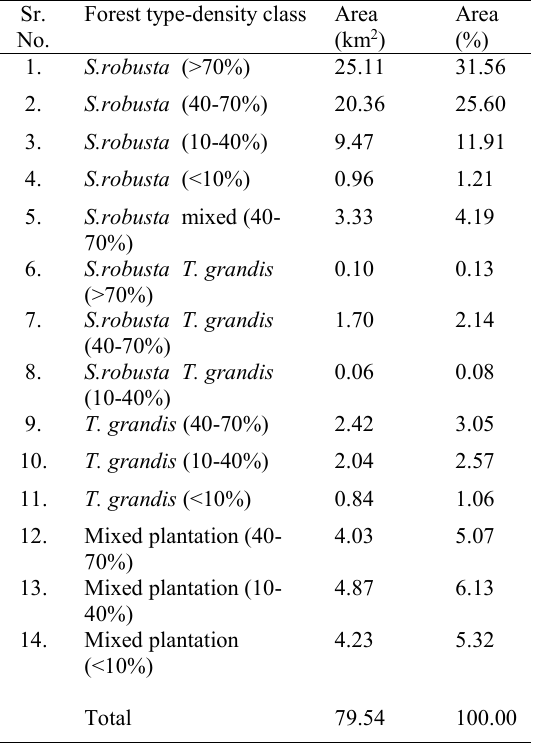
Table 1 Area under forest type-density